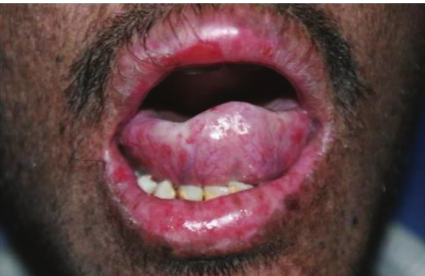
Figure 6: Decreased mouth opening affecting oral